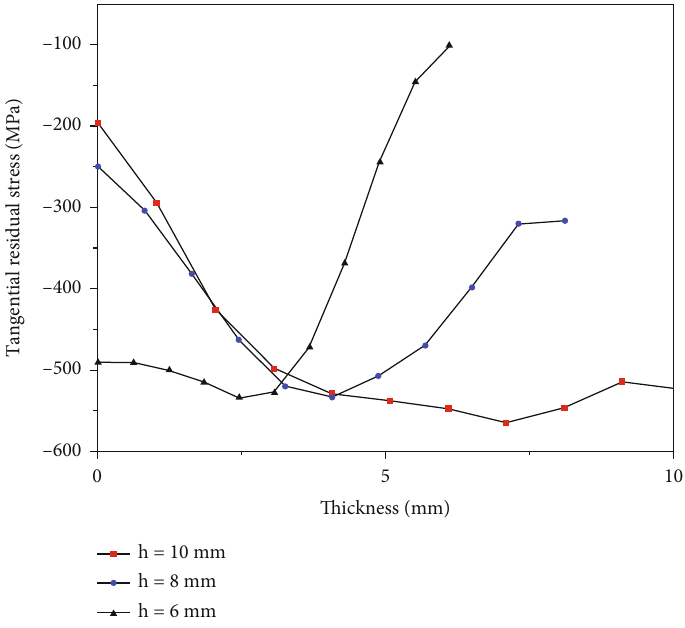
Figure 7: The tangential residual stress varies with the thickness of the substrate under di ff erent